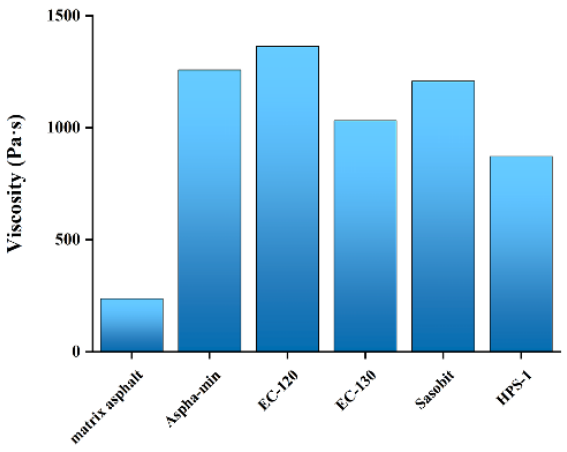
Figure 3. Dynamic viscosity of asphalt at 60 °C.